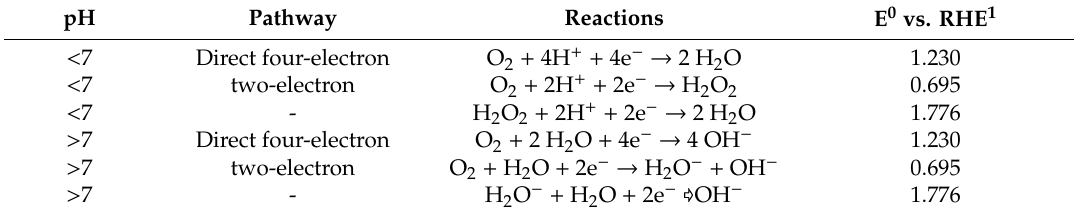
Table 1. Oxygen reduction reaction (ORR) mechanisms in acidic and alkaline media. pH Pathway